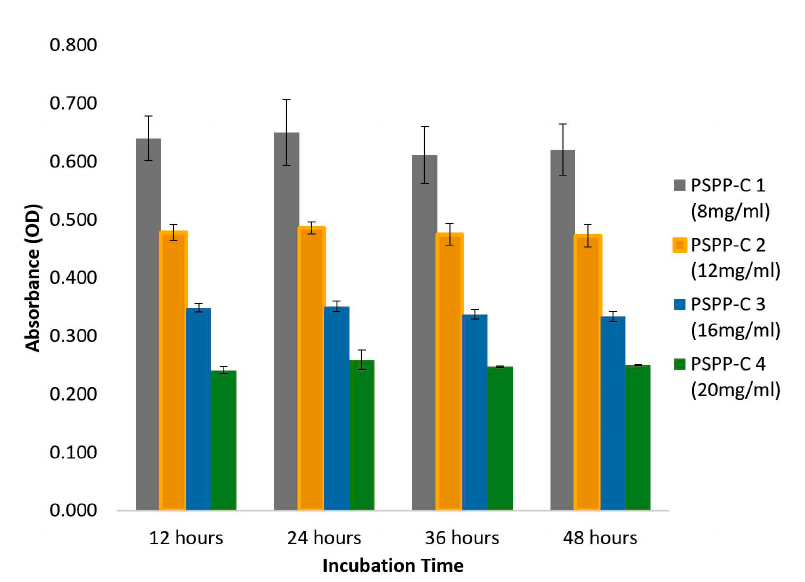
Fig. 5. Antibiofilm activity of chloroform extract of Piper aduncum against Pseudomonas aeruginosa over 48 hours of